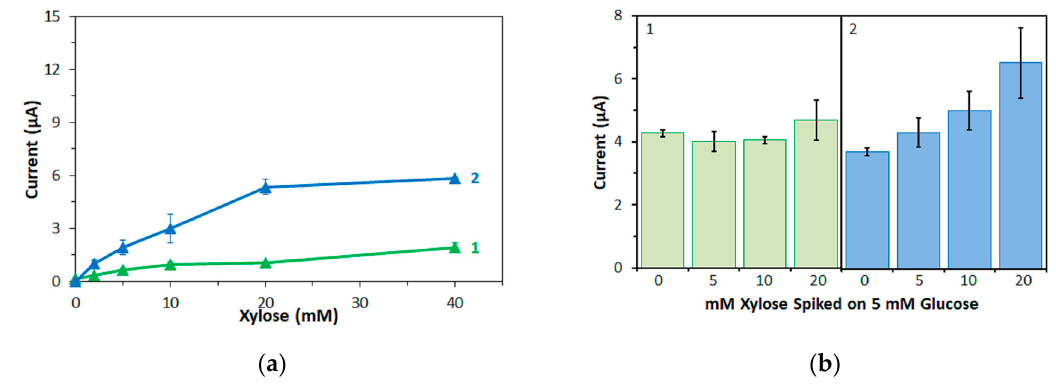
Figure 6. ( a ) Dependency of current at 5 s after application of the potential on the xylose concentration. Figure ( b ) Response current to 5 mM glucose spiked with different amounts of xylose. Enzyme: (1) FADGDH  (QY); (2) Af GDH. Mediator: mPMS.